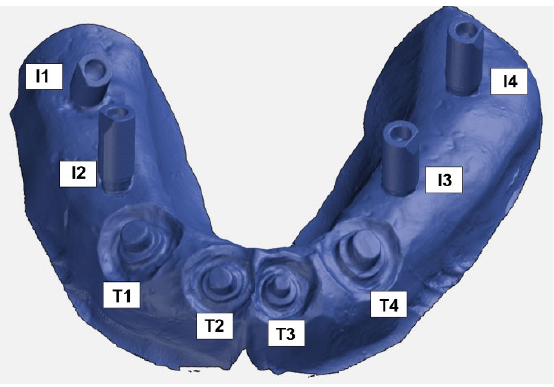
Figure 9. Parameters included in the analysis: T1–T4 (teeth) and I1–I4 (implants).